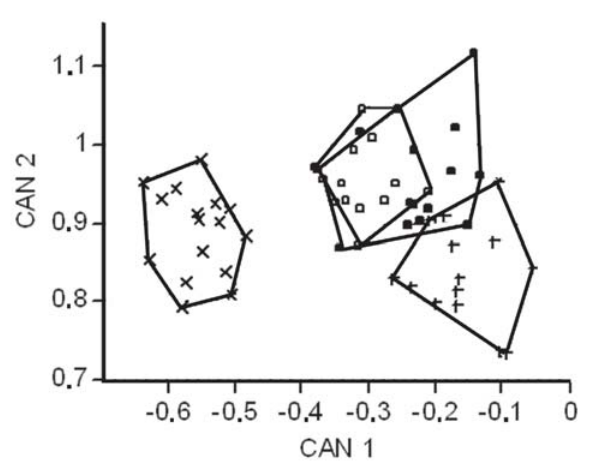
Fig. 4. Distribution of the individual scores of the size-free canonical variate combining the samples from the Vila Velha State Park localities (Furna 2) (x), rio Tibagi (+), Lagoa Dourada (light square) and rio Cará-cará (shaded